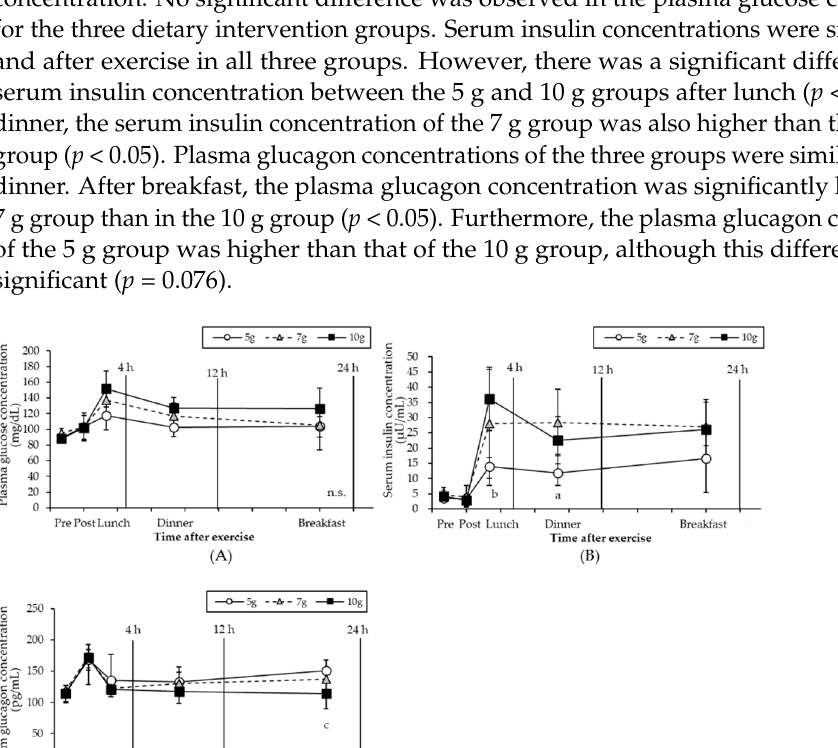
Figure 3. Recovery rate of muscle glycogen concentration over 24 h for the three carbohydrate intake amounts—a: 5 g vs. 7 g groups, p < 0.05; b: 5 g vs. 10 g groups, p < 0.05; values are expressed as mean ± standard deviation.